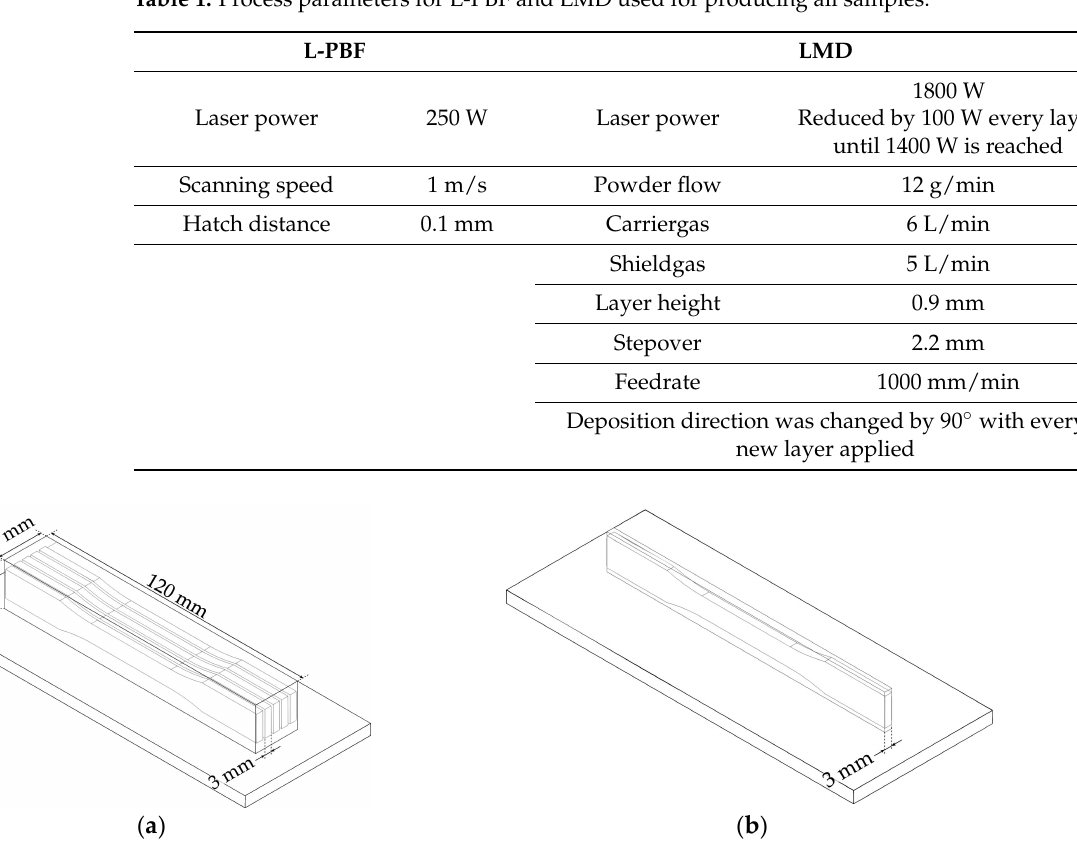
Figure 2. Manufacturing process of tensile strength specimens. ( a ) : LMD, ( b ) : L-PBF. Heat treatment was performed for 6 h at 490 °C with subsequent air-cooling to room temperature. Vickers hardness measurements HV10 were conducted on polished samples using an ATM Carat 930 hardness tester (ATM—Advanced Materialography GmbH, Mammelzen, Germany). Quasi-static tensile tests were conducted on a